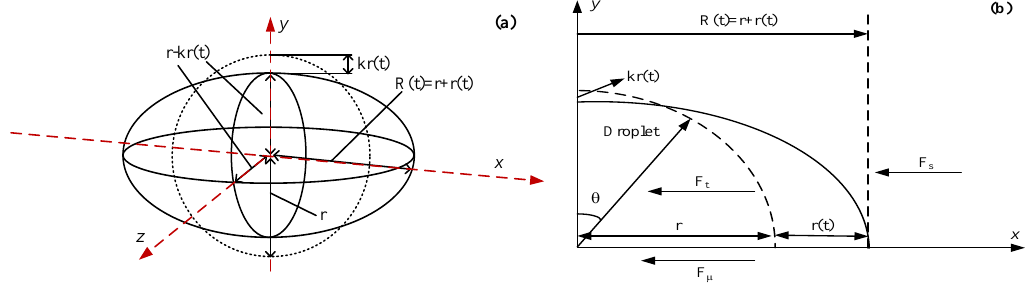
Figure 2. Geometrical model for theoretical analysis: ( a ) three-dimensional; ( b ) two-dimensional.